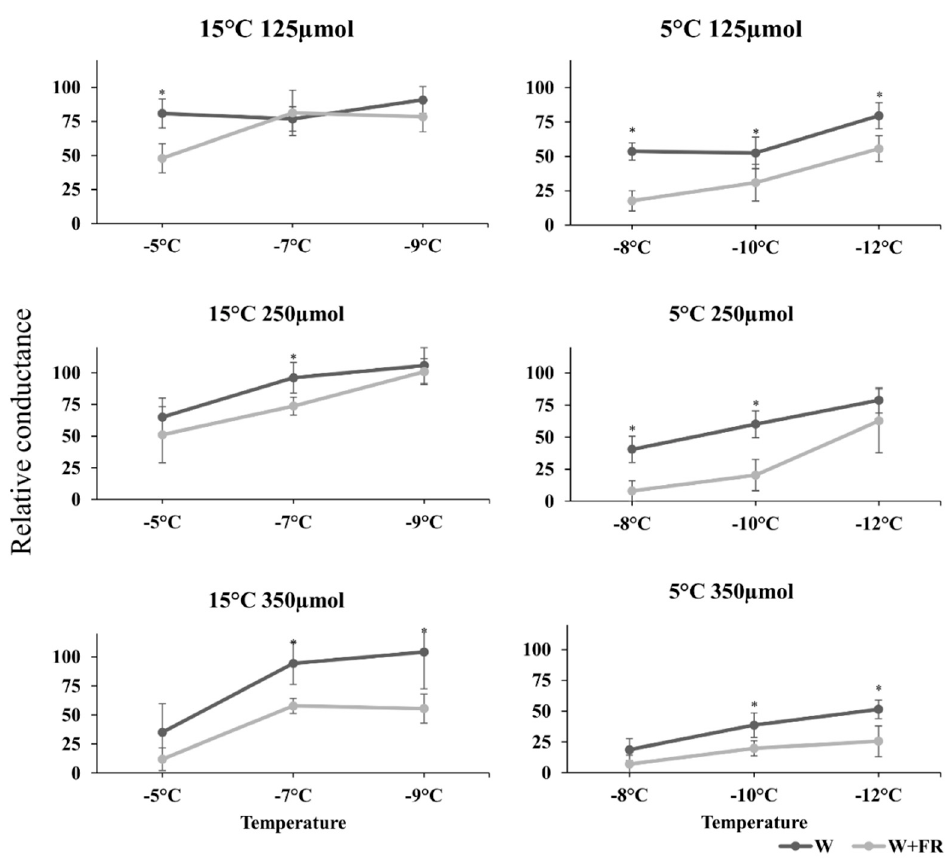
Figure 4. The effects of the supplementary far-red light treatments on freezing tolerance under various light intensities in barley plantlets. The X -axis shows the freezing temperatures while the Y -axis refers to the relative conductance values (percentage of the lethality). In each case, the samples were collected on the last day of the treatments. In 15 ◦ C temperature tables it means the 10th day, while in the 5 ◦ C temperature tables it was on the 7th day. The data and error bars, which represent the standard deviation, originated from five biological replicates.